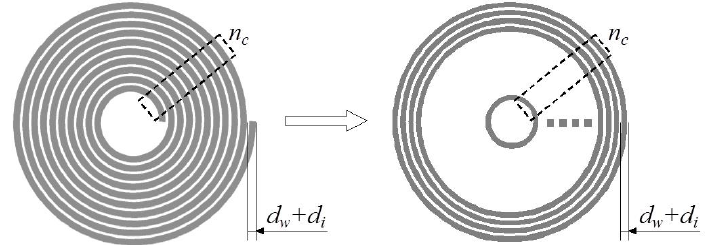
Figure 6. Spiral coil approximation for resistance calculation, using concentering circles.